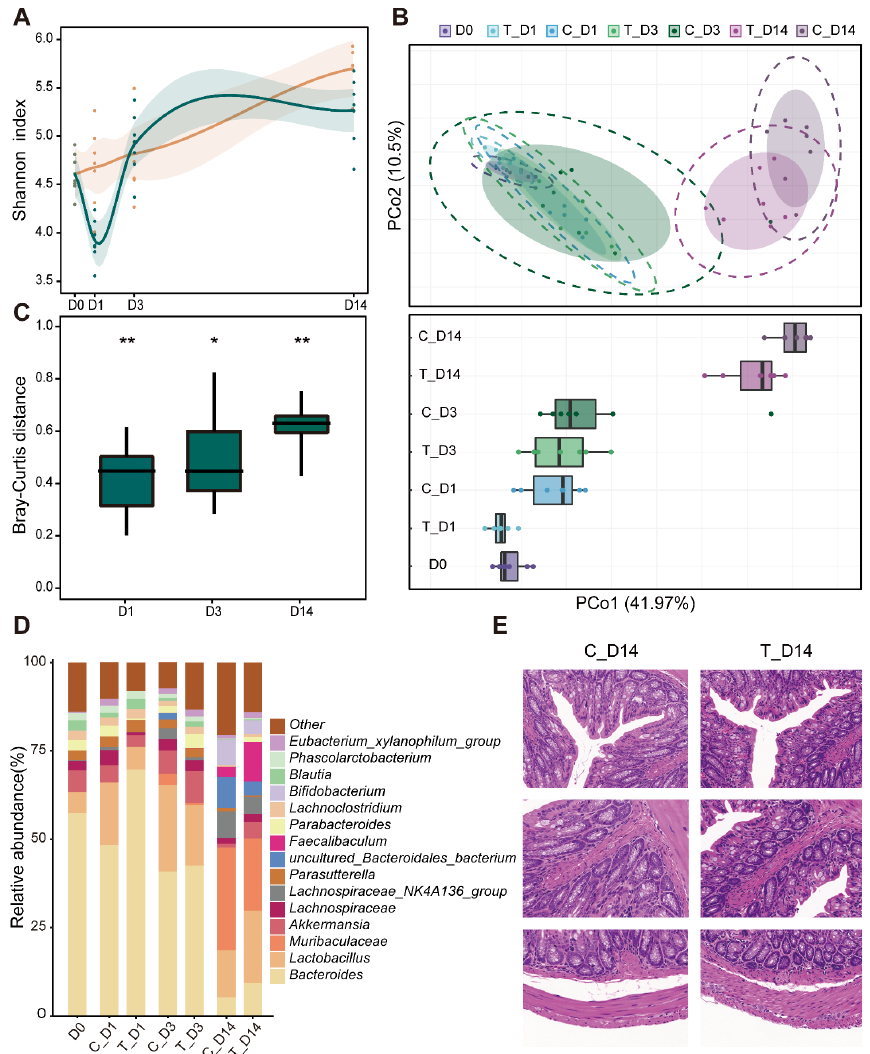
Figure 6. PEG treatment leads to corresponding changes in humanized mice. ( A ) Changes in the Shannon index of the experimental and control groups. Curve fitting is conducted by the “LOESS” method. The shadow around the curve shows a 95% confidence interval. ( B ) The Bray–Curtis PCoA plot shows the differences between different groups of mice at different time points (top panel). The microbiota composition of the different groups at each time point shows obvious differences (bottom panel). ( C ) The Bray–Curtis distance between microbiota of the experimental and control groups at every time point. ( D ) Percentage bar graph showing the relative proportion of bacterial genera in each group. ( E ) Comparison of HE-stained colon sections of the control group and the experimental group at day 14. p > 0.05, * p < 0.05; ** p < 0.01; T, polyethylene glycol (PEG) treatment group; C, control